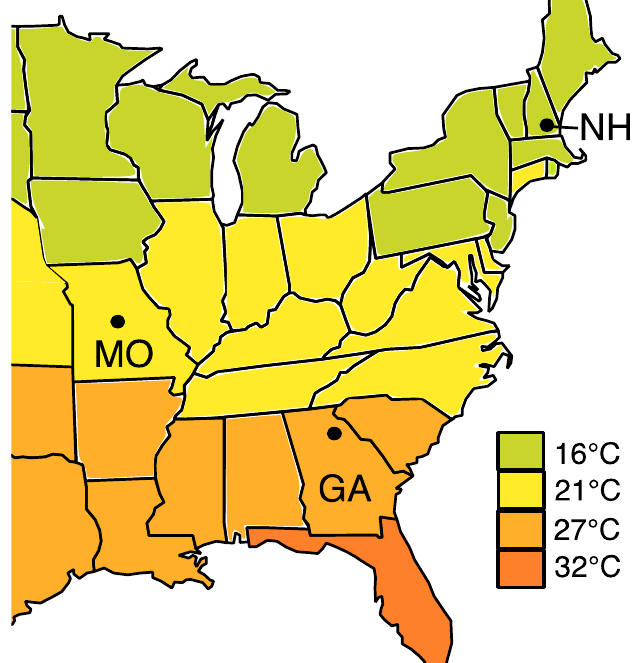
Figure 1. Map showing the average summer temperatures (°C) across the eastern United Sates. Black dots indicate the sampled regions of GA: Georgia, MO: Missouri and NH: New Hampshire. Map was modified from the National Oceanic and Atmospheric Administration (http://www.noaa.gov/climate).